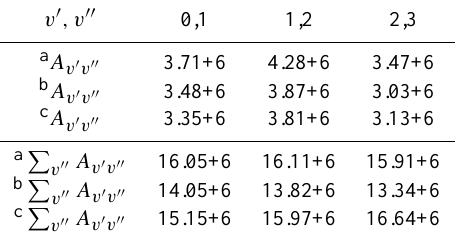
Table 2. Franck-Condon factors from Gilmore et al. (1992) a and Lofthus et al. (1977) b .